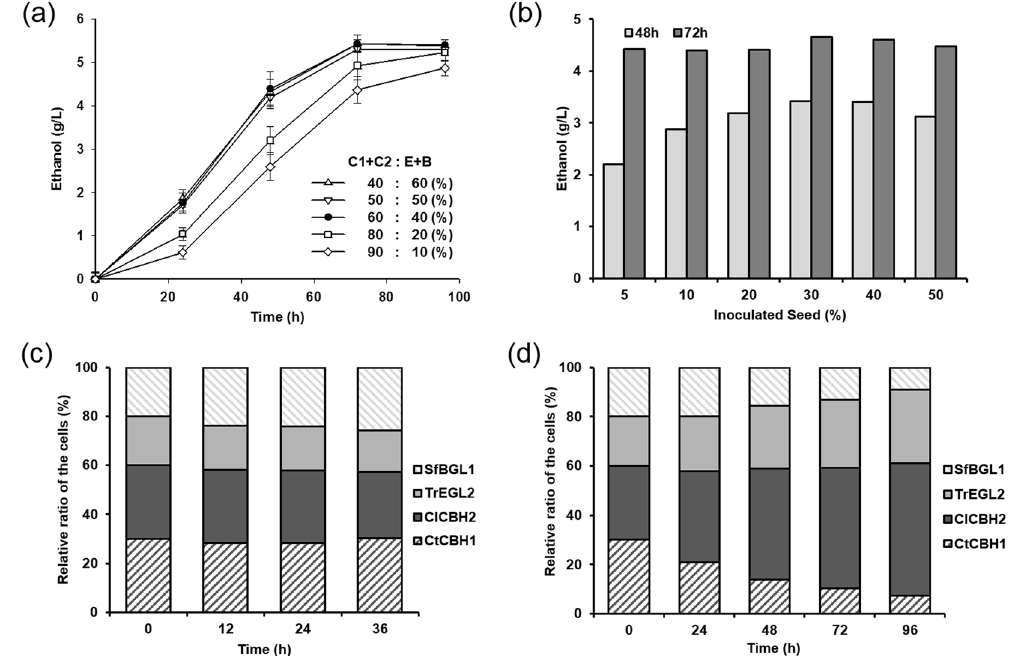
Figure 7. Optimization of the KYC composition. ( a ) Ethanol production from MI-Avicel by the KYC with various exocellulase compositions (from 40% to 90%) was analysed to find the optimal ratio of exocellulases in the KYC mixture. Experiments were performed in triplicate and repeated three times. ( b ) Ethanol production from 2% MI-Avicel was analysed at 72 h with various amount of seed (5–50%). ( c ) The relative ratio of the cells harbouring each cellulase expression vector was quantified by qPCR during the mixed cultivation of the KYC3322 either in YPD for 36h, and ( d ) in ethanol fermentation medium, including 2% (w/v) MI-Avicel, for